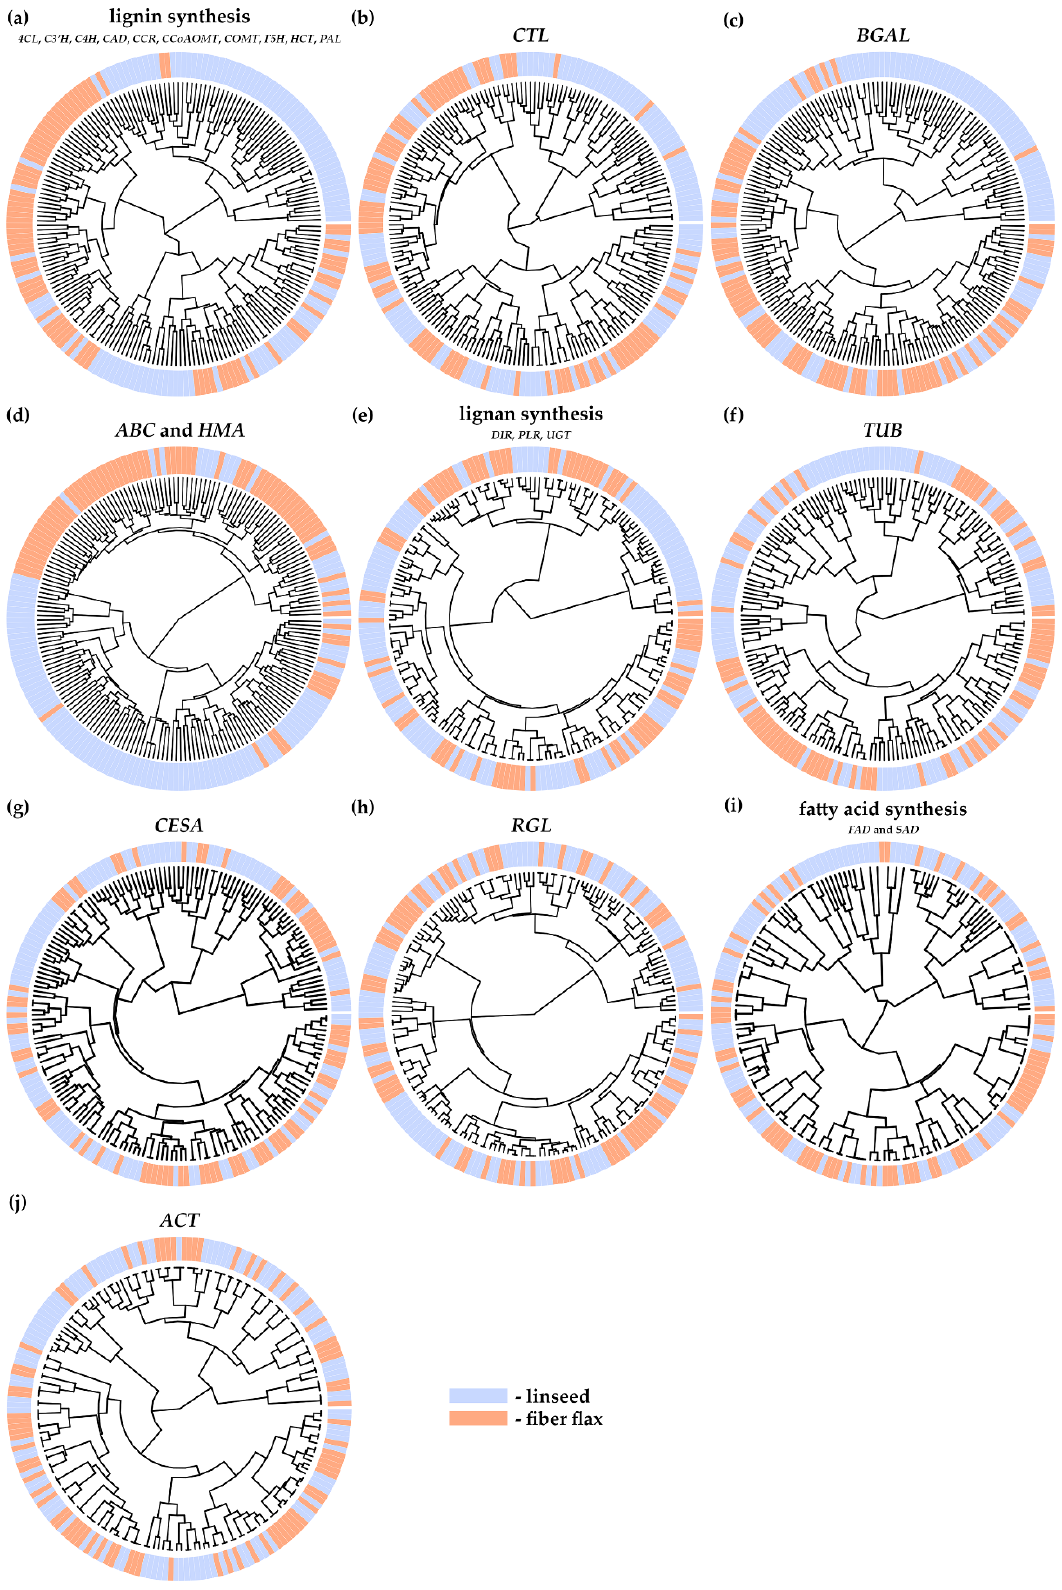
Figure 3. Clustering of linseed and fiber flax varieties based on polymorphisms in lignin-associated ( 4CL , C 3′ H , C4H , CAD , CCR , CCoAOMT , COMT , F5H , HCT , and PAL ) ( a ), CTL ( b ), BGAL ( c ), ABC and HMA ( d ), lignan-associated ( DIR , PLR , and UGT ) ( e ), TUB ( f ), CESA ( g ), RGL ( h ), fatty acid – associated ( FAD and SAD ) ( i ), and ACT ( j ) gene families.